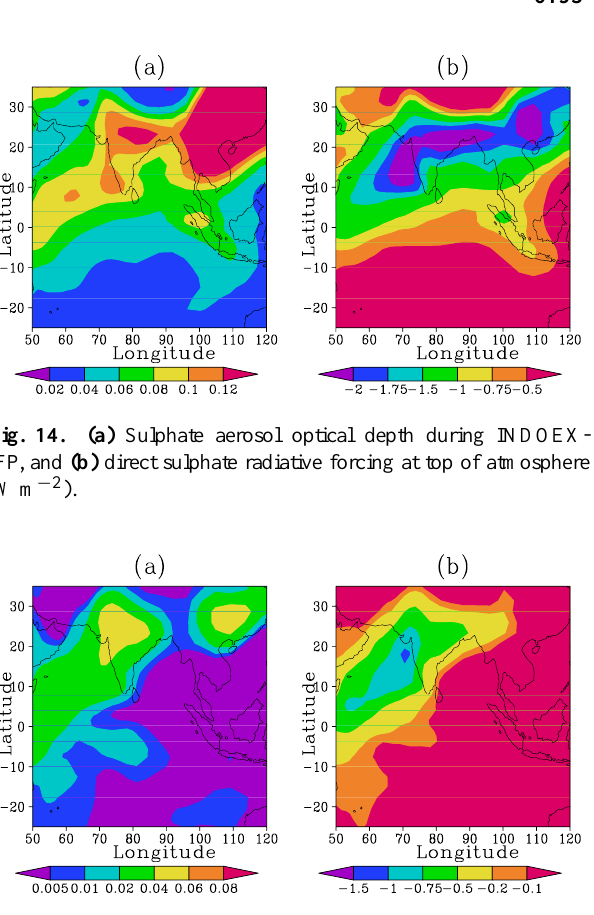
Fig. 15. Simulated differences from the use of two inventories (a) Sulphate aerosol optical depth during INDOEX-IFP, and (b) direct sulphate radiative forcing at top of atmosphere (Wm − 2